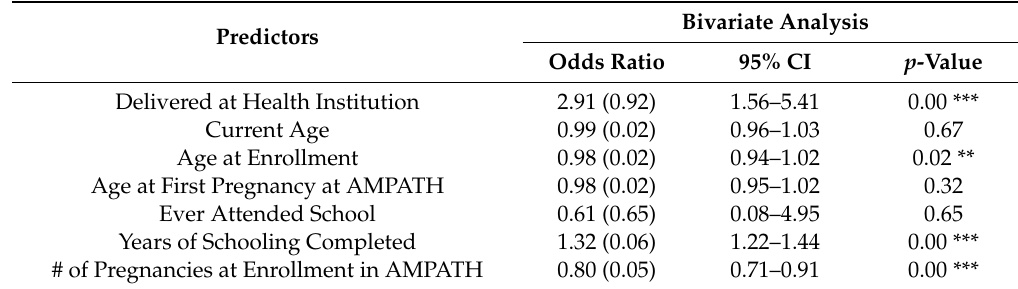
Table 2. Predictors of Health Insurance Enrollment among HIV positive Pregnant